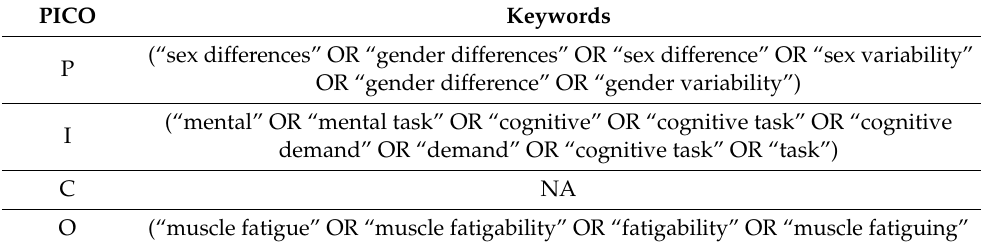
PICO (“sex differences” OR “gender differences” OR “sex difference” OR “sex variability” P OR “gender difference” OR “gender variability”) (“mental” OR “mental task” OR “cognitive” OR “cognitive task” OR “cognitive demand” OR “demand” OR “cognitive task” OR “task”)